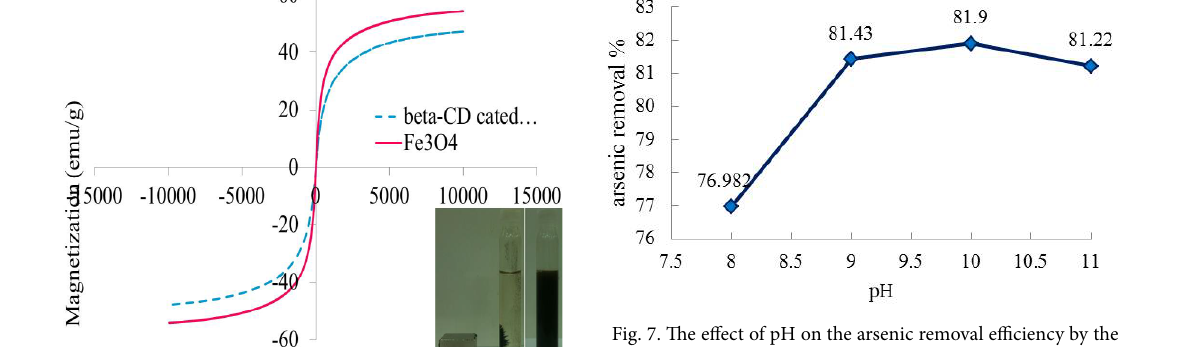
Fig. 7. The effect of pH on the arsenic removal efficiency by the Fig. 7 The effect of pH on the arsenic removal efficiency by the β -CD β-CD modified Fe O nanoparticle The removal studies 3 4 were carried out by applying 6mg/ml β-CD-modified modified Fe 3 O 4 nanoparticle The removal studies were carried out by applying Fig. 6 Magnetic hysteresis curves of naked (solid line) and β -CD modified (dot Fig. 6. Magnetic hysteresis curves of naked (solid line) and β-CD O on the As(III) solution with 10 ppm concentration, Fe 3 4 modified (dot line) Fe O nanoparticles during 10 min contact time at room 6mg/ml β -CD-modified Fe 3 O 4 on the As(III) solution with 10 ppm concentration, line) Fe 3 O 4 nanoparticles. 3 4 during 10 min contact time at room temperature).